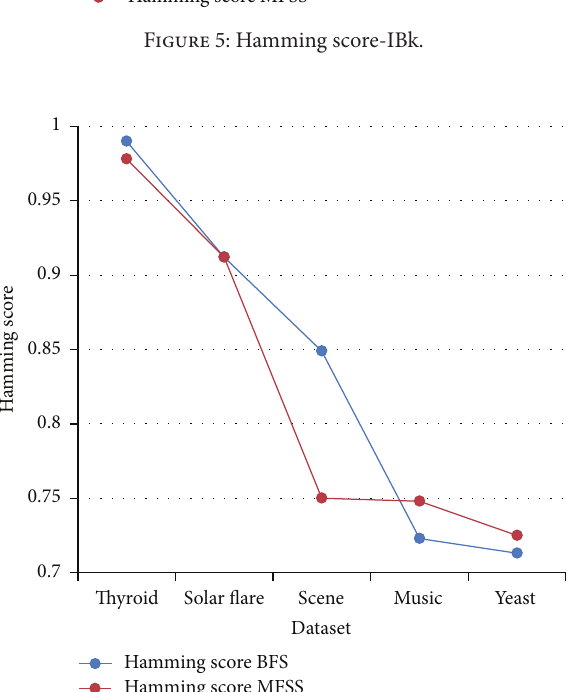
Figure 5: Hamming score-IBk.